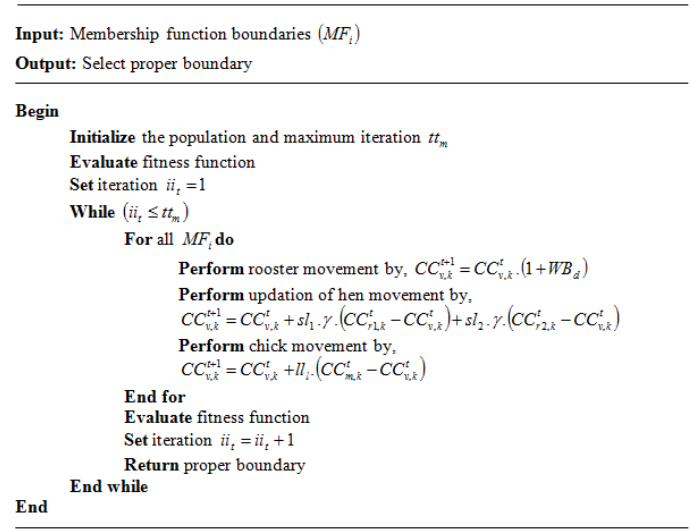
Figure 5. Pseudocode for the WDCSO.